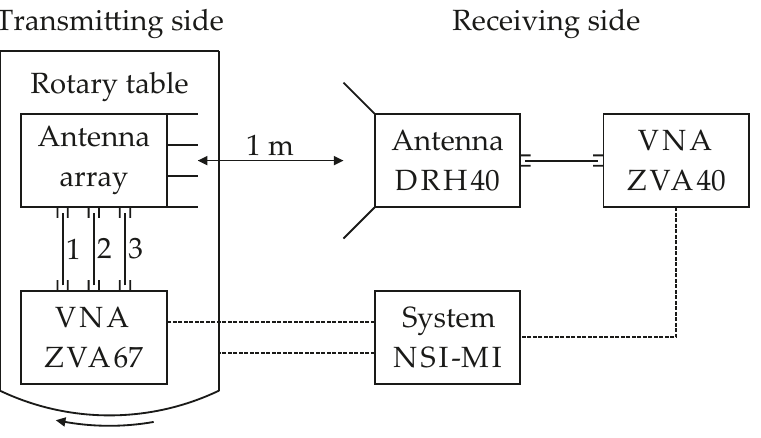
Figure 5. Magnitude of simulated and measured S-parameters of antenna array: ( a ) reflection coefficients S nn , n and ( b ) transmission coefficients S 1 n , n according to Figure 3.